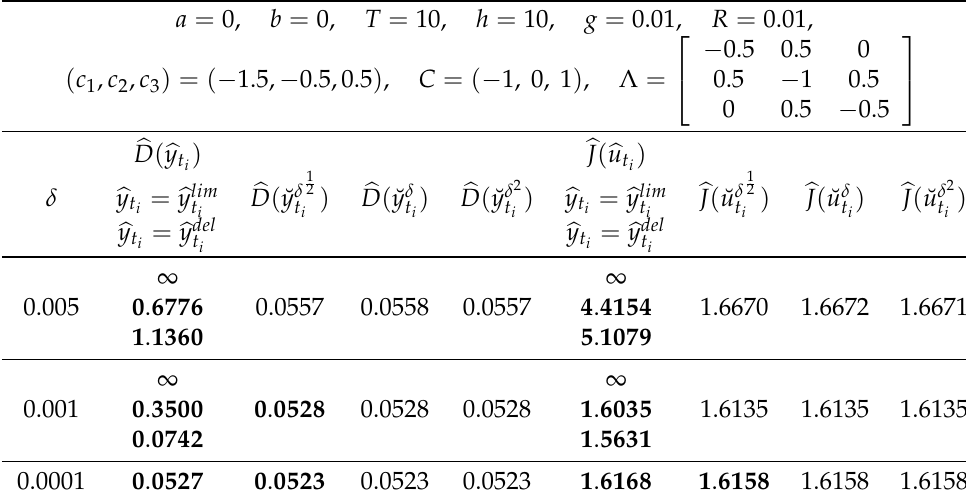
Table 3. The results of the third numerical experiment.